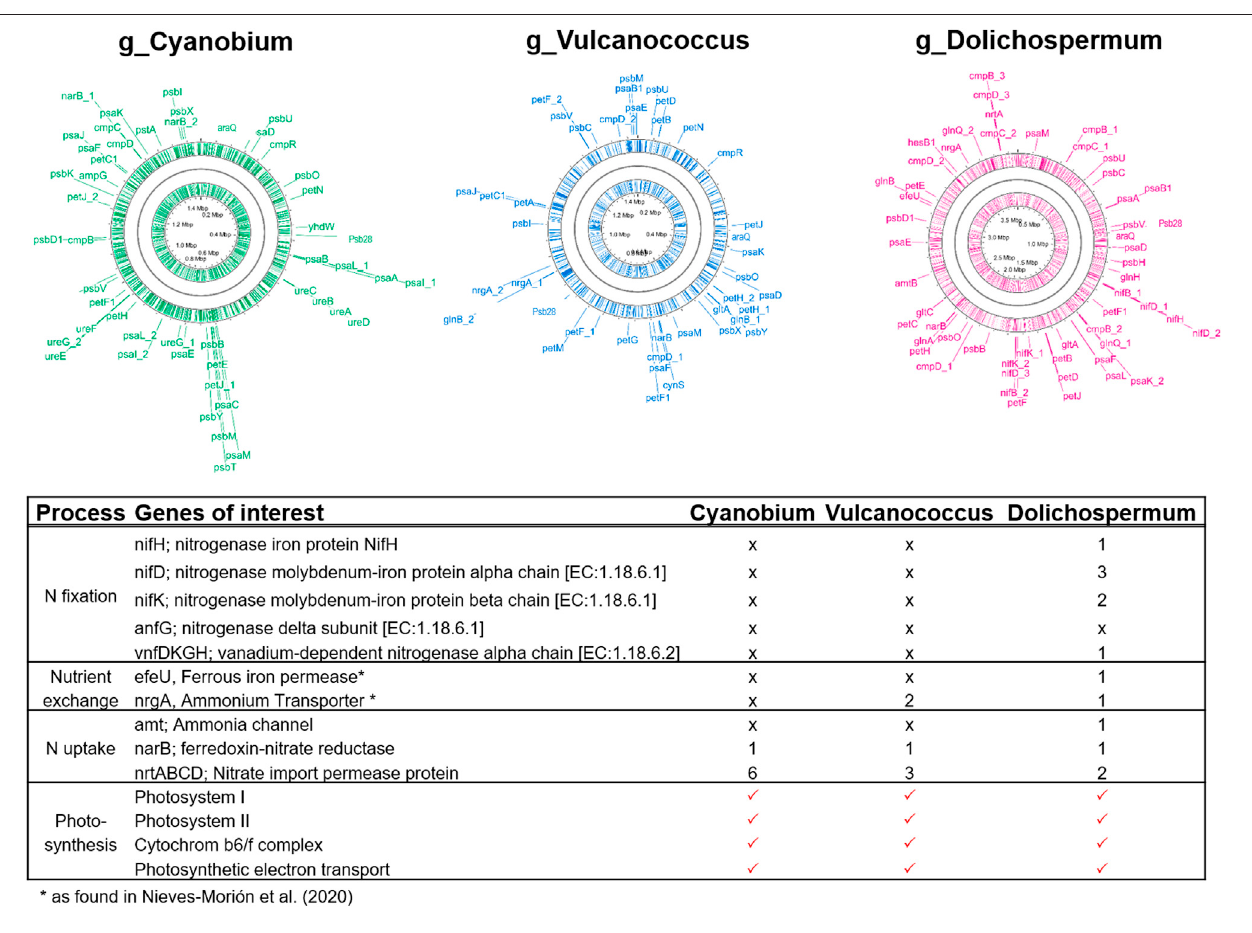
FIGURE 9 | Genes involved in nitrogen fi xation ( nifHDK , anfG , and vnfDKGH ), dissolved inorganic nitrogen uptake ( amt , narB , and nrtABCD ), and photosynthesis from the metagenome assembled genomes identi fi ed as the picocyanobacteria Cyanobium and Vulcanococcus as well as the fi lamentous cyanobacterium Dolichospermum . nrgA and efeU are responsible for nitrogen and iron exchange in Dolichospermum -diatom symbioses, respectively (Nieves-Morión et al., 2020).